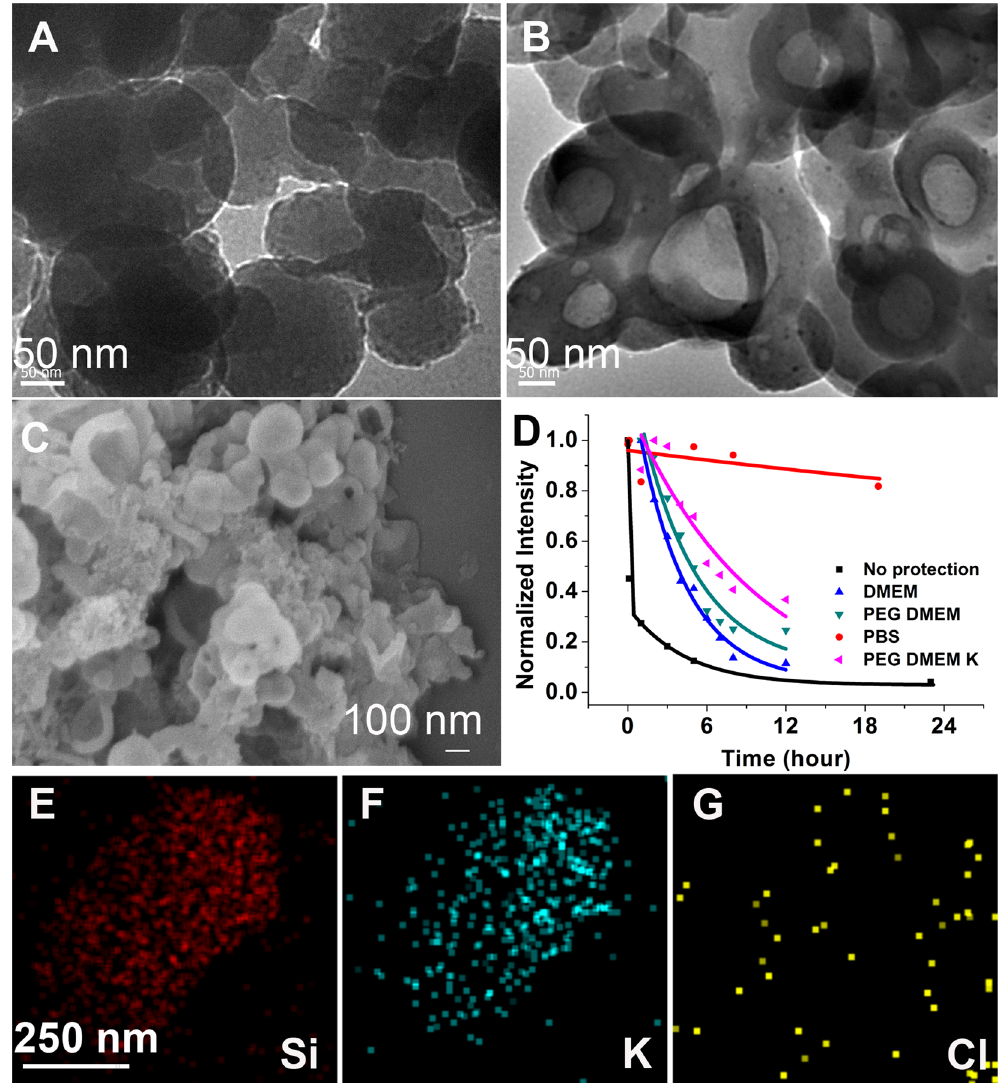
Figure 6. Improved silica stability. ( A + B ) TEM images of larger AgND@SiO 2 after 5 min ( A ) and 9 h ( B ) incubation in DMEM. Scale bars, 50 nm. ( C ) SEM image of the sample in ( B ). Scale bar, 100 nm. ( D ) Comparison of luminescence intensity decay of silver nanodots under various conditions. ( E – G ) EDS images of the above AgND@SiO 2 in PBS showing the signal of silicon ( E ), potassium ( F ) and chlorine ( G ). Scale bars, 250